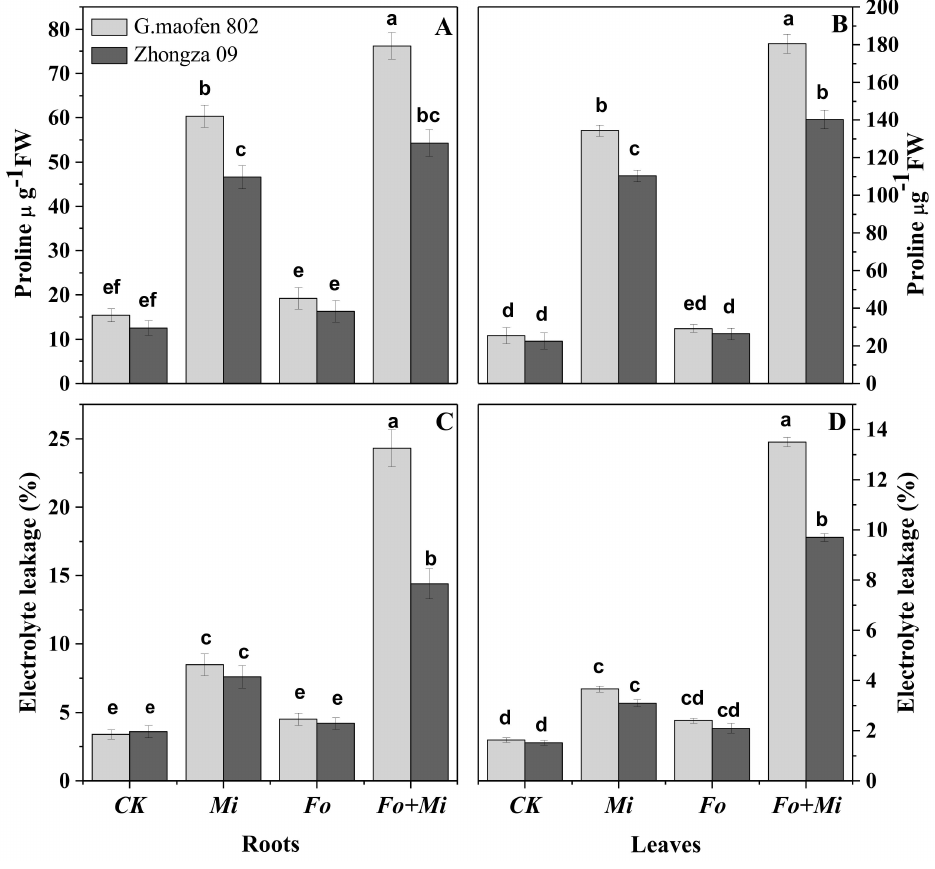
Figure 5. E ff ects of Fusarium oxysporum and Meloidogyne incognita alone and in combination on proline contents ( A , B ) and electrolyte leakage ( C , D ) of two tomato cultivars (G. maofen 802 and Zhongza